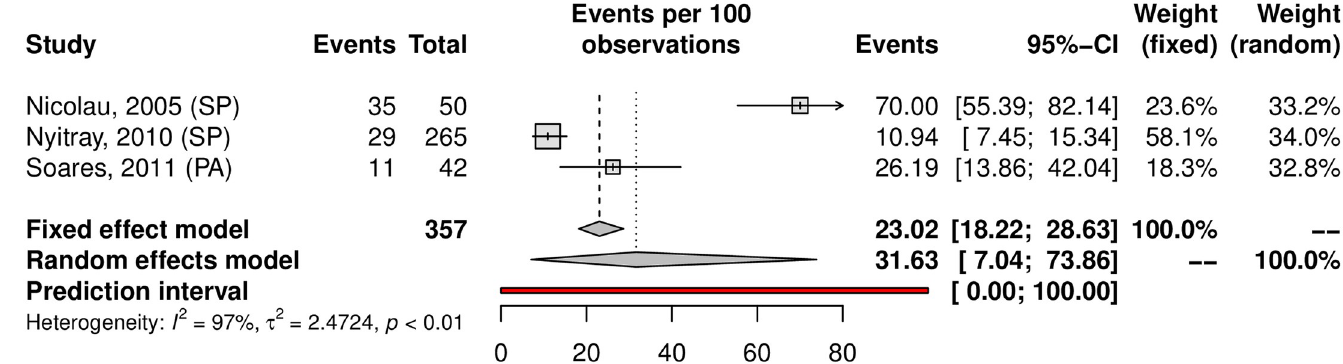
Fig 19. Prevalence of anal HPV infection in high-risk populations. Forest plot of a metanalysis of studies reporting prevalence of anal infection by HPV in high-risk populations in Brazil.